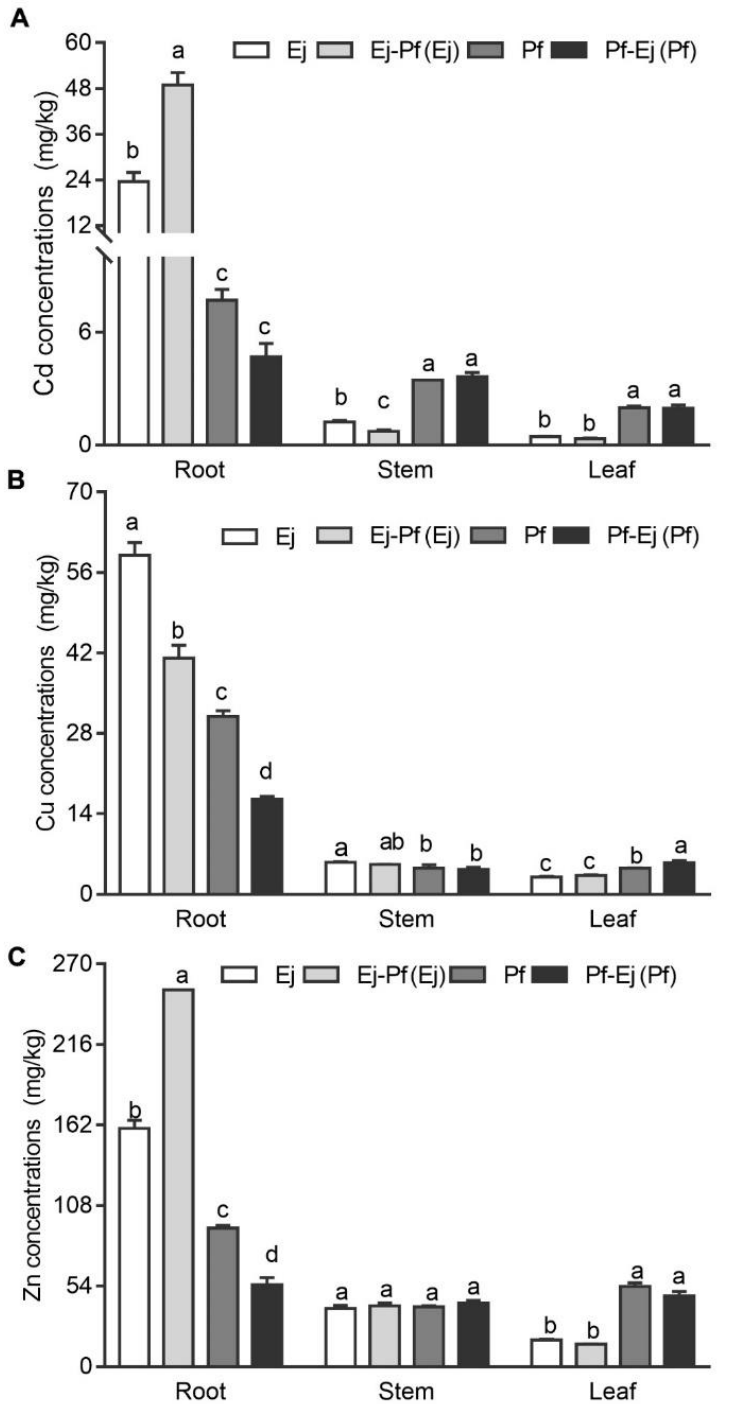
Figure 2. The Cd, Cu, and Zn concentrations of P. × fraseri and E. japonicus in the monoculture and intercropping systems. Ej and Pf refer to E. japonicus and P. × fraseri in the monoculture system, respectively; Ej-Pf and Pf-Ej (Pf) refer to E. japonicus and P. × fraseri in the intercropping system, respectively. The concentrations of Cd ( A ), Cu ( B ), and Zn ( C ) in the root, stem, and leaf for P. × fraseri and E. japonicus , respectively. All values are presented as the mean ± standard error ( n = 4), and bars with different lowercase letters indicate significant ( p < 0.05) differences between the treatments and control, according to Duncan’s